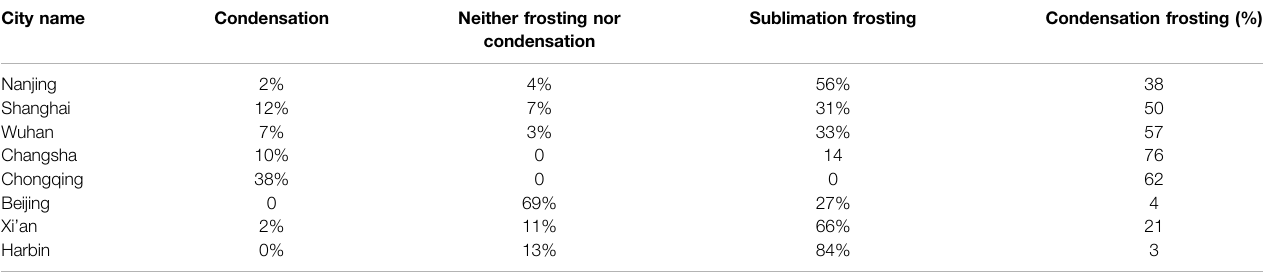
TABLE 1 | The proportion of frosting type in typical cities at Δ t (cid:1) 10 °